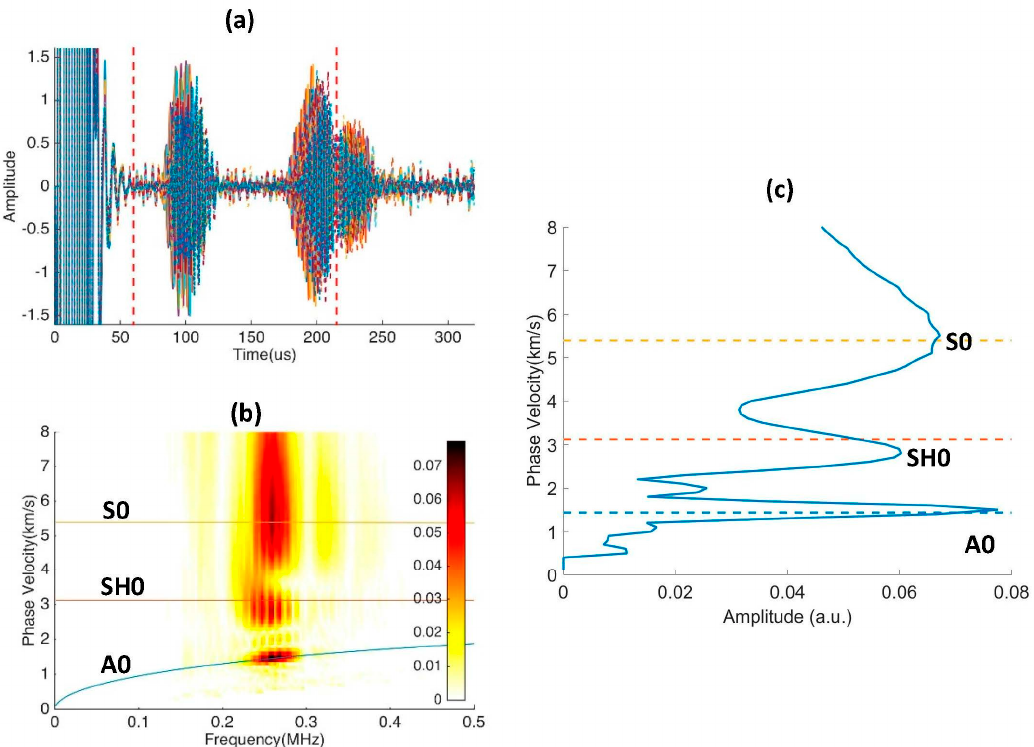
Figure 13. Experiment results for modal decomposition experiment. Signal window is taken from 60 to 220 µs to include all incident modes. ( a ) A-scan signals of 16 channels in the multi-element PVDF sensor; ( b ) Phase velocity-frequency spectrum superimposed on phase velocity dispersion curves; ( c ) Phase velocity spectrum showing the amplitude of the A0, SH0, and S0 modes.